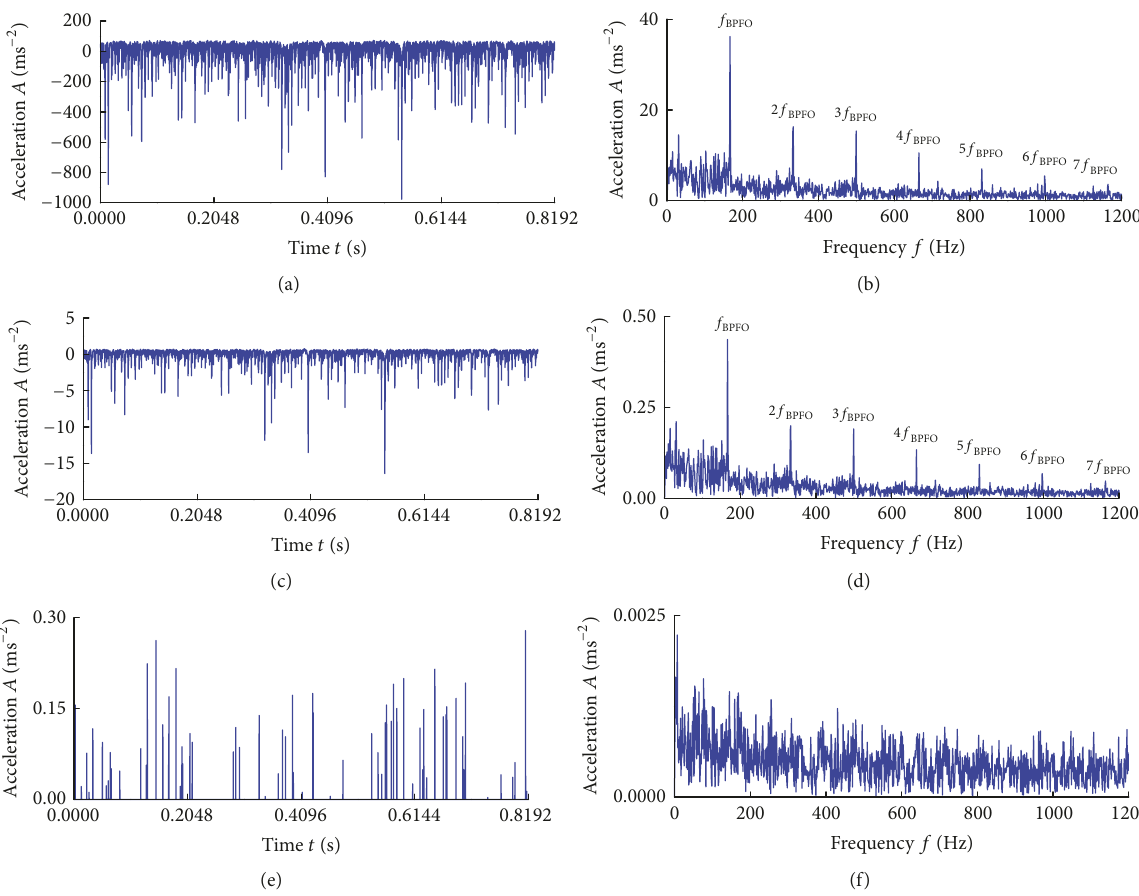
Figure 10: The intrinsic envelopes learned by the impulse-envelope manifold and their envelope spectra: (a) impulse-envelope with Isomap, (b) the envelope spectra of (a), (c) impulse-envelope with LLC, (d) the envelope spectra of (c), (e) impulse-envelope with LTSA, and (f) the envelope spectra of (e).